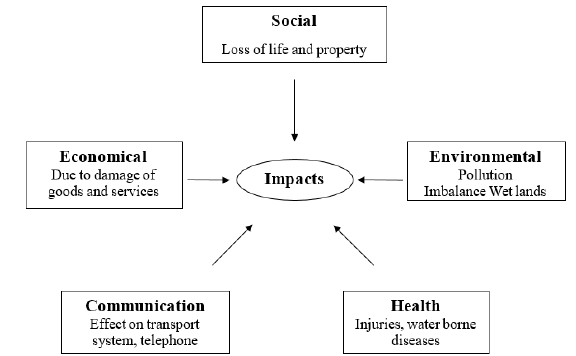
Figure 1: Impacts of Urban